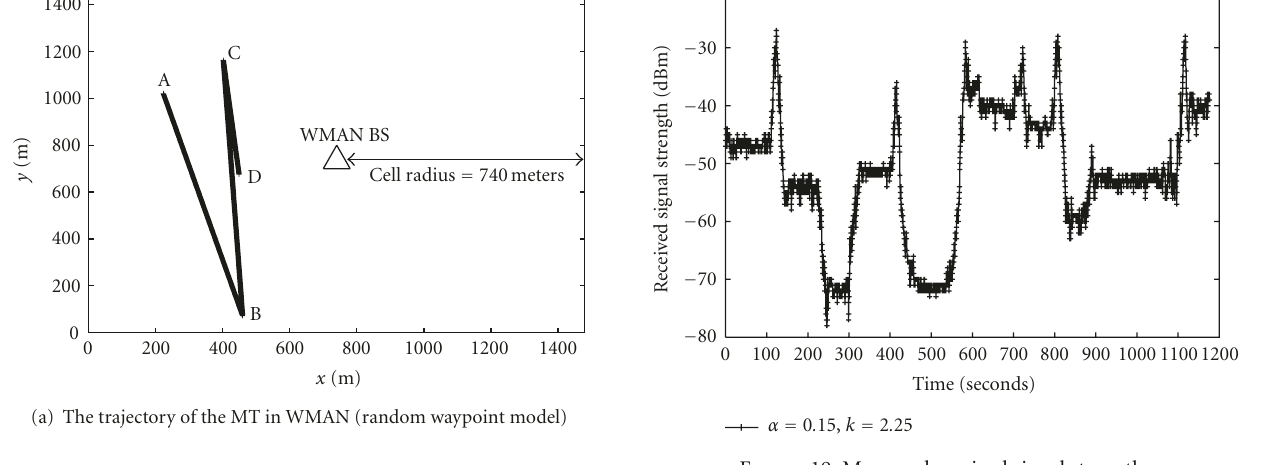
Figure 19: Measured received signal strength.